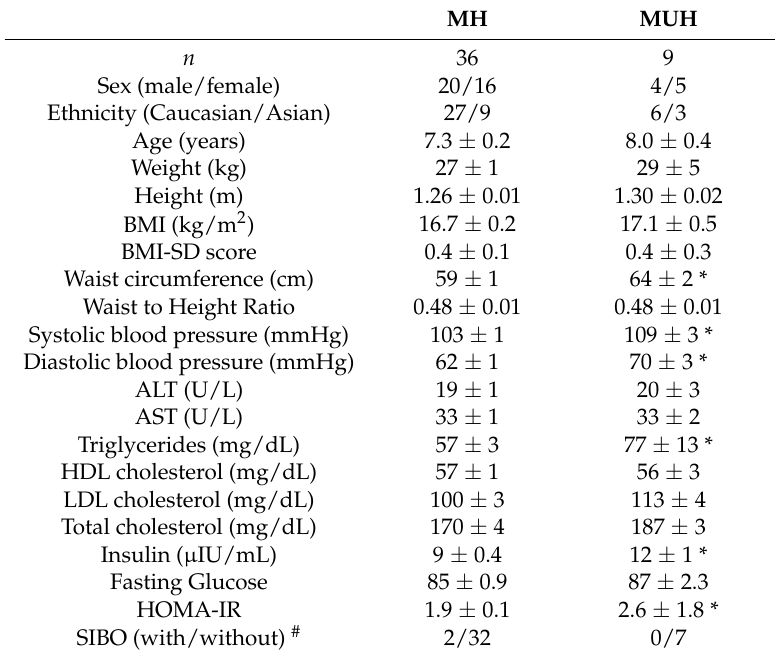
Table 1. Characteristics of healthy children and children suffering from metabolic